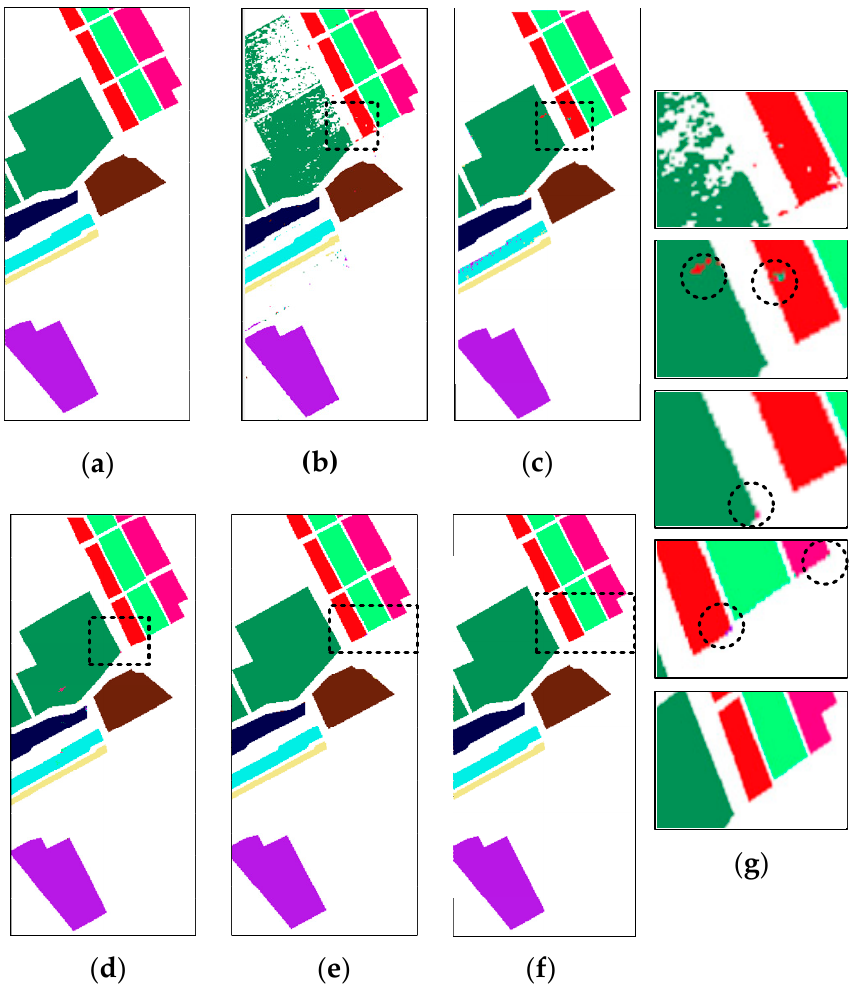
Figure 9. Classification maps from the proposed DANCE-DRCNN method and the baselines on the Salinas-small data: ( a ) ground truth; ( b ) SVM-PCA; ( c ) PCA-CNN; ( d ) 3D-CNN; ( e ) DRCNN; ( f ) DANCE-DRCNN; ( g ) enlarged edge image.